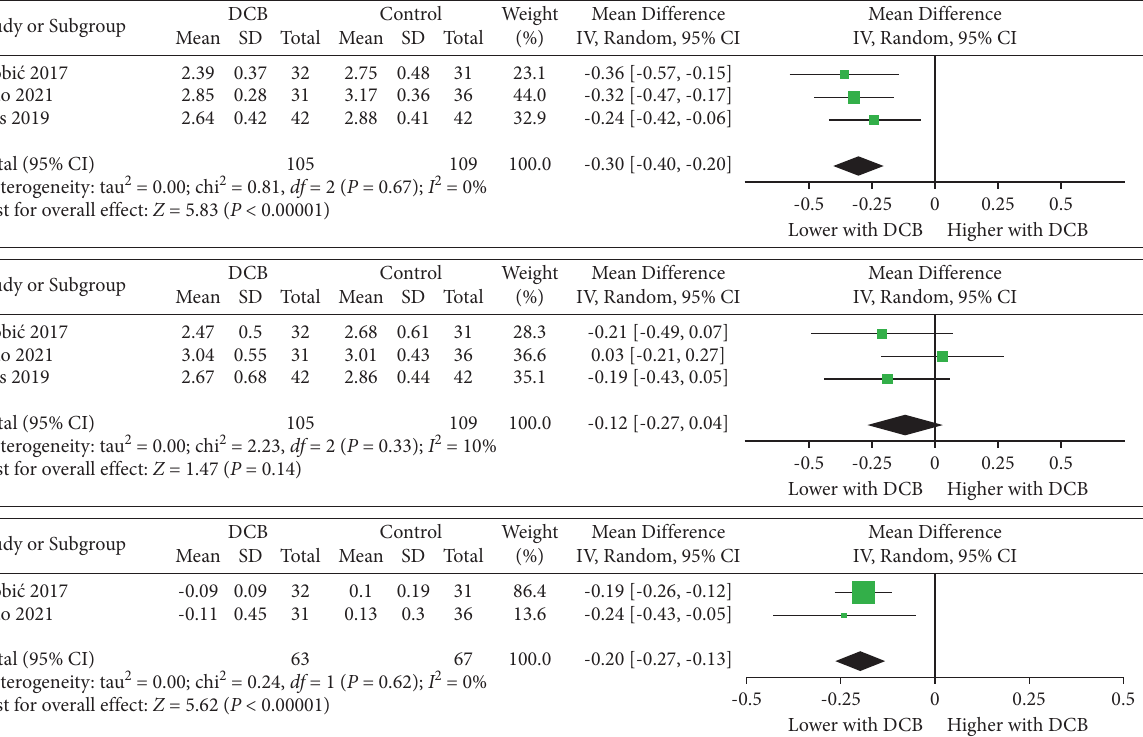
Heterogeneity: tau 2 = 0.00; chi 2 = 0.81, df = 2 ( P = 0.67); I 2 = 0% Test for overall effect: Z = 5.83 ( P <